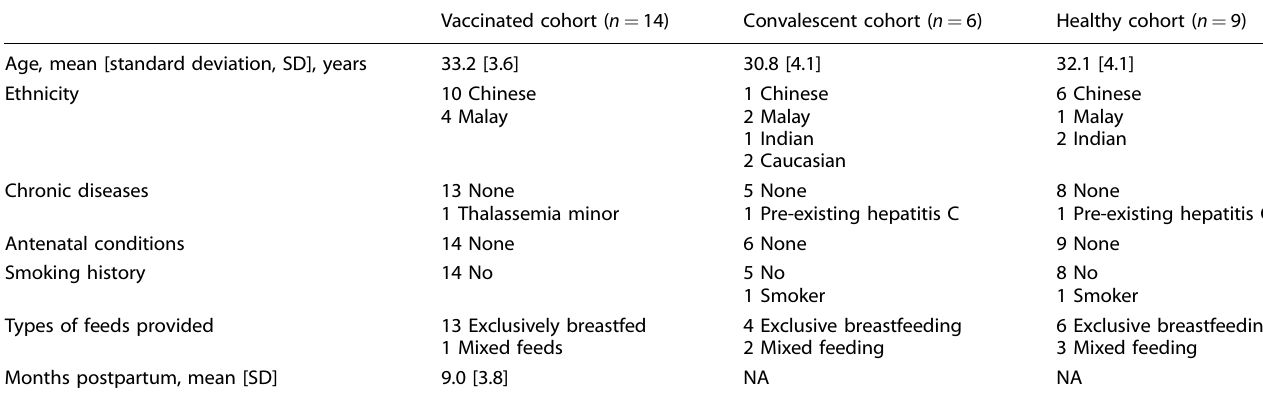
Table 1. Clinical and demographic features of vaccinated cohort, convalescent cohort, and healthy cohort of